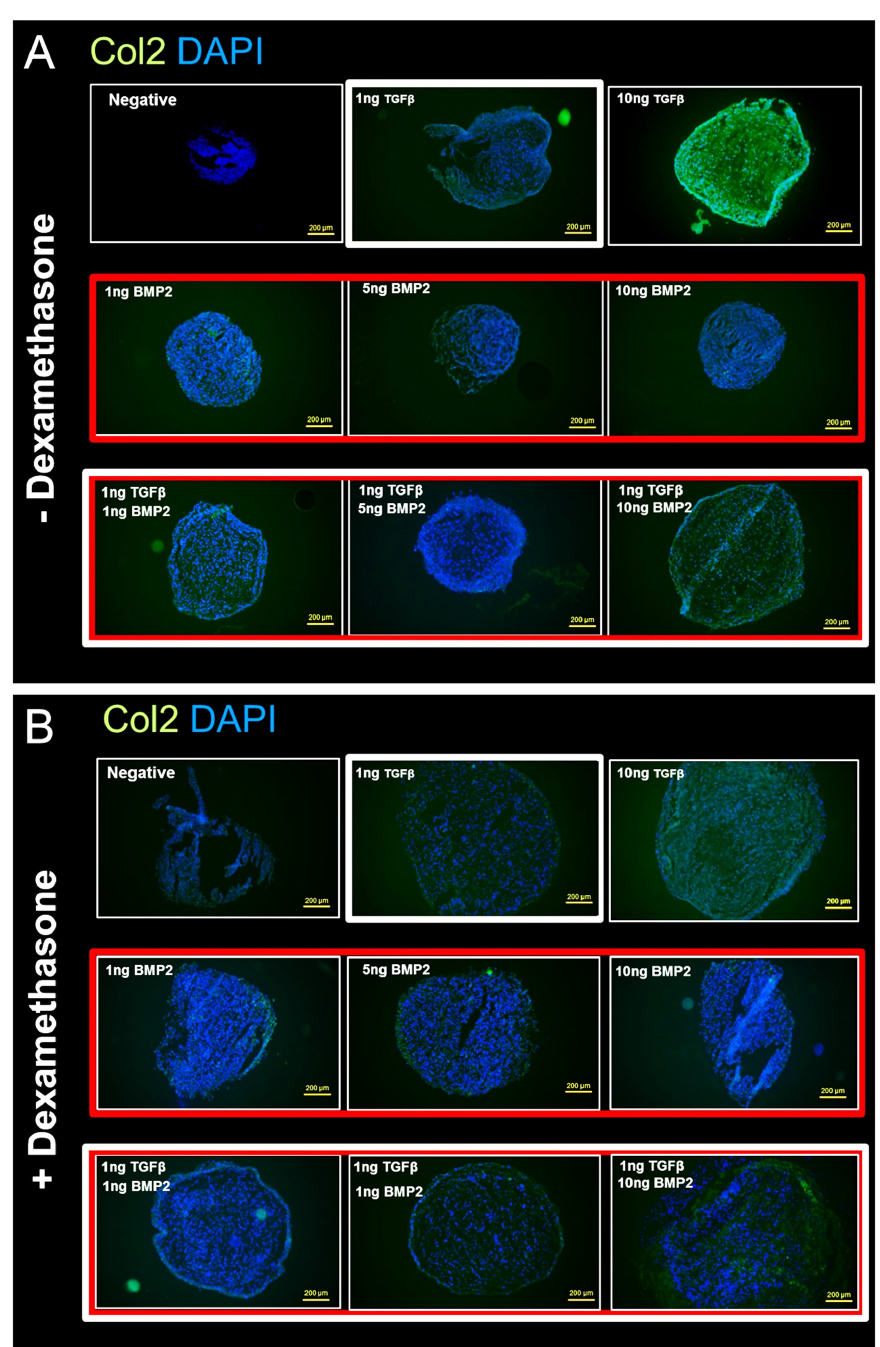
Figure 7. Immunofluorescence for type II collagen / DAPI on hSDSC pellets exposed to TGF- β 1 and BMP-2 in the presence ( B ) or absence ( A ) of dexamethasone. hSDSCs in 3D culture were cultured for 21 days in the presence of 10 ng / mL TGF- β 1 (positive control) or in its absence (negative), low TGF- β 1 concentration (1 ng / mL TGF- β 1), various concentration of BMP-2 alone (1 ng / mL BMP-2, 5 ng / mL BMP-2, 10 ng / mL BMP-2) or BMP-2 in combination with 1 ng / ml TGF- β 1 (1 ng / mL TGF- β 1 + 1 ng / mL BMP-2, 1 ng / mL TGF- β 1 + 5 ng / mL BMP-2 and 1 ng / mL TGF- β 1 + 10 ng / mL BMP-2). The intensity of type II collagen antigen reaction was comparable to the Safranin-O / Fast Green staining. Green color represents the positive reaction to type II collagen. Cells were stained blue with DAPI. The figures are representative of four separate experiments in four di ff erent donors. Yellow scale bar is 250 µ